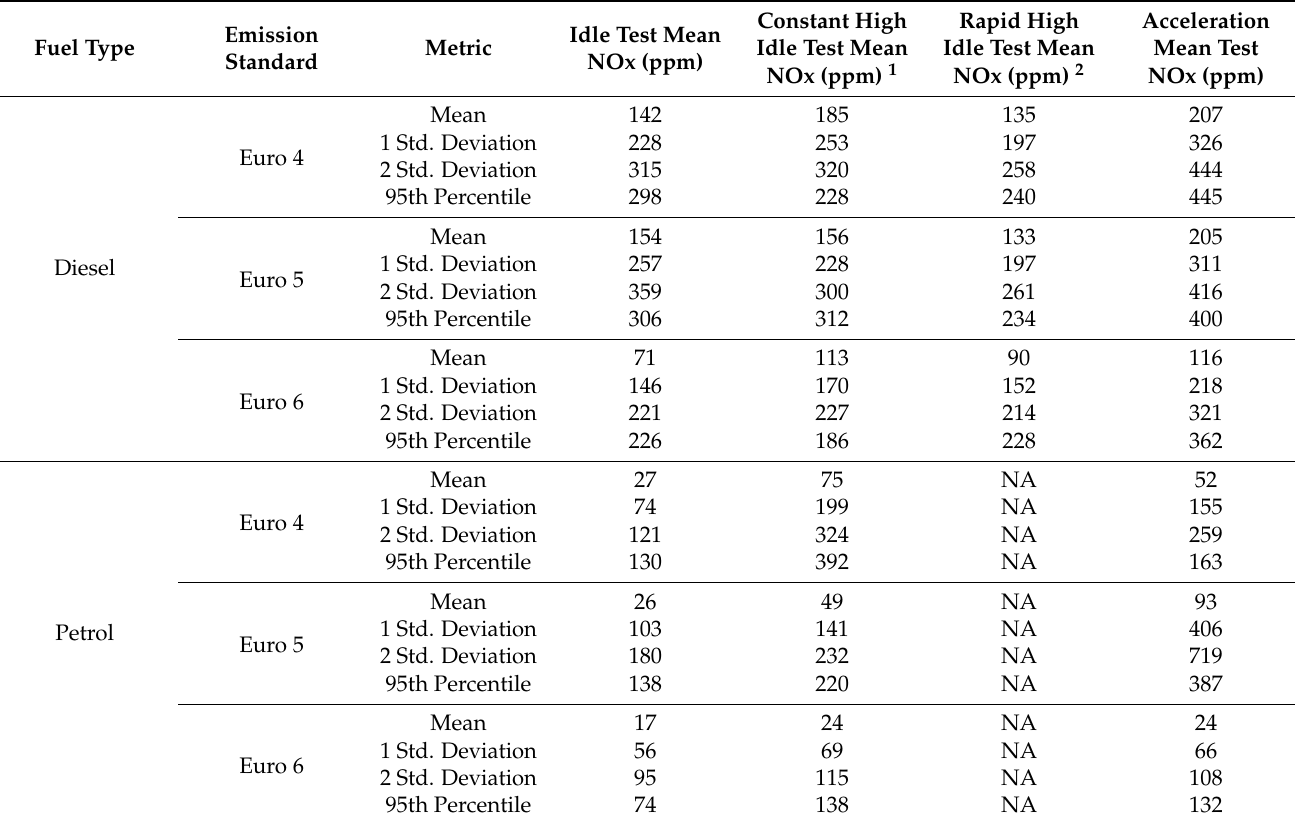
Table 3. Fleet-average NOx results over each test, alongside the first and second standard deviations from the mean value, and the 95th percentile value. In keeping with the results presented in Section 3.2.1, the mean NOx concentration is the chosen metric for all test